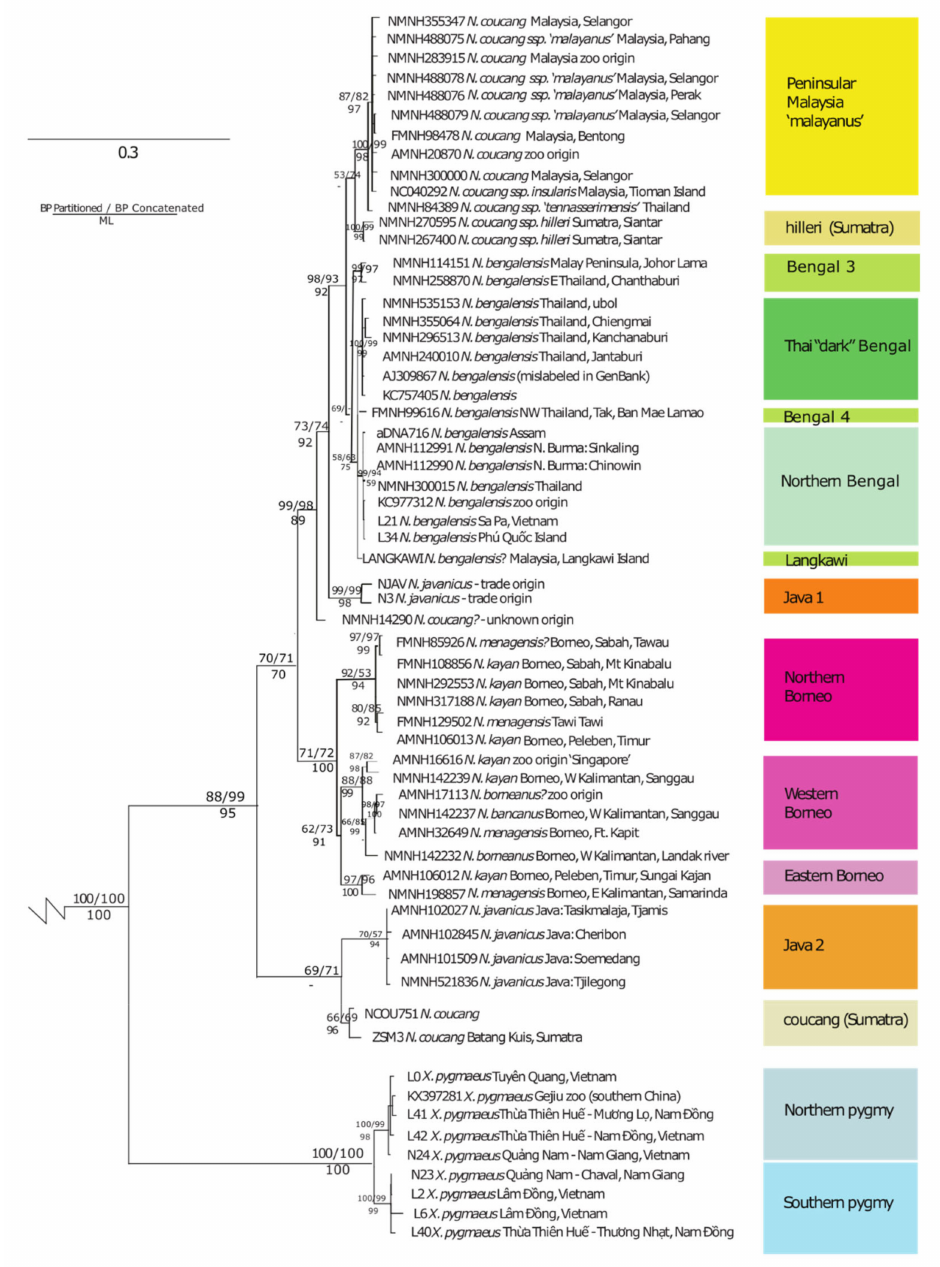
Figure 2. Phylogenetic tree inferred from maximum likelihood and Bayesian analyses. Node values are reported for Bayesian posterior probability above the line (both partitioned and concatenated analyses results are shown; 100 means PP = 1.0) and maximum likelihood bootstrap support (%) below the line. Scale bar represents substitutions per